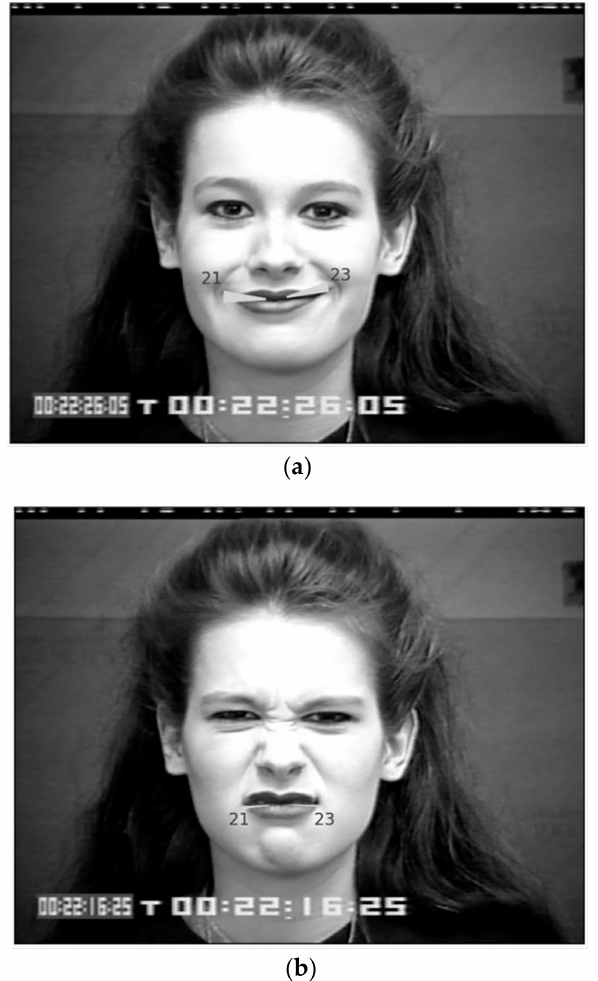
Figure 9. Annulus sectors 21 and 23 corresponding, respectively, to two induced rule granules are displayed along the mouth on a human face regarding the classes ( a ) “happiness”, thus confirming the participation of AU6 (Cheek Raiser) and AU12 (Lip Corner Puller), and ( b ) “anger”, thus confirming the participation of AU23 (Lip Tightener) (©Jeffrey